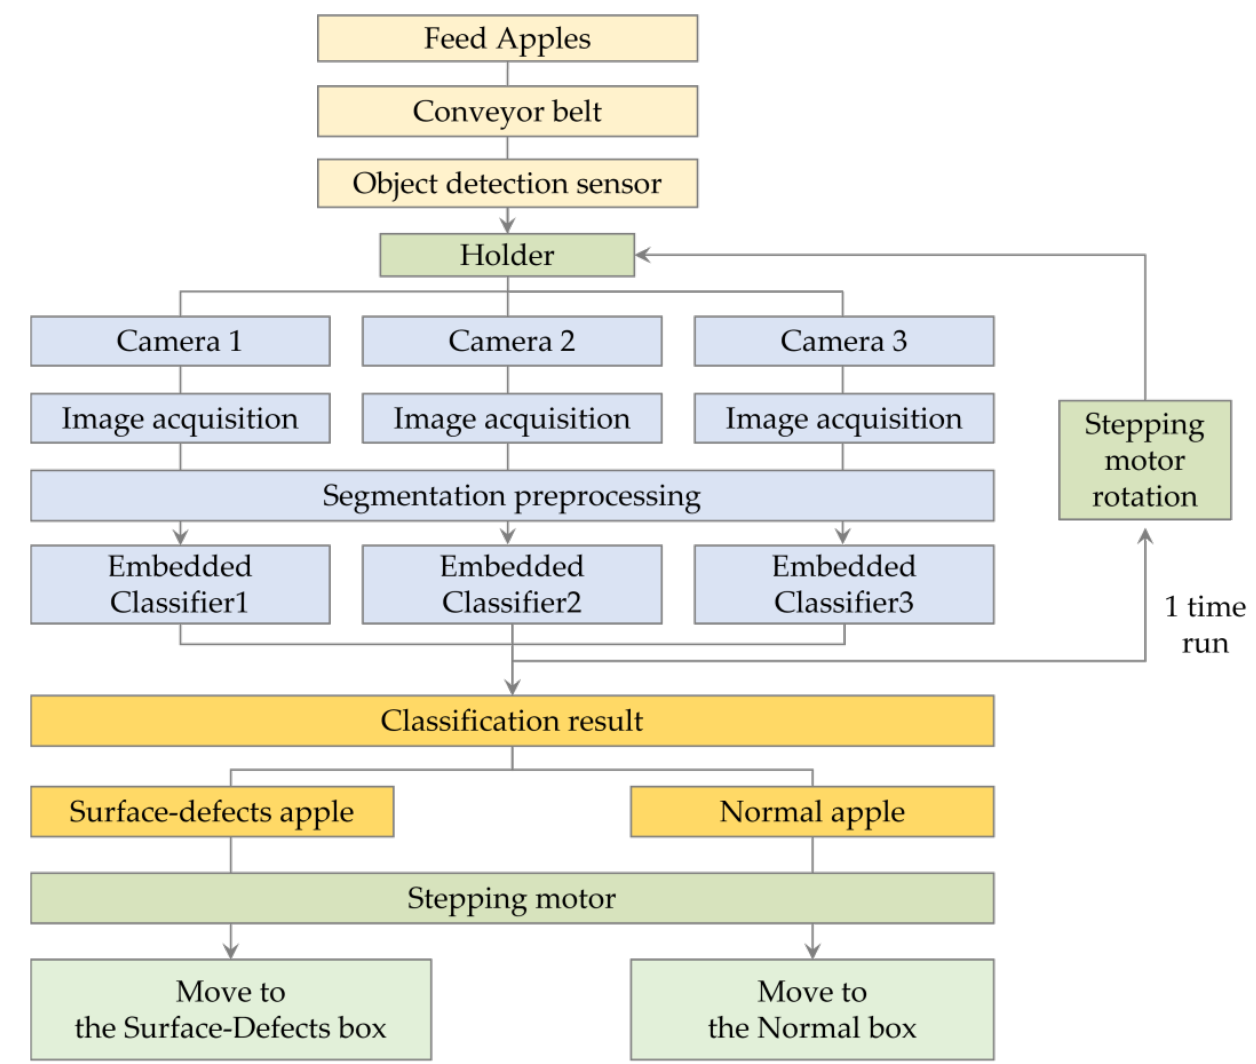
Figure 2. The workflow of the defective apple sorting system.